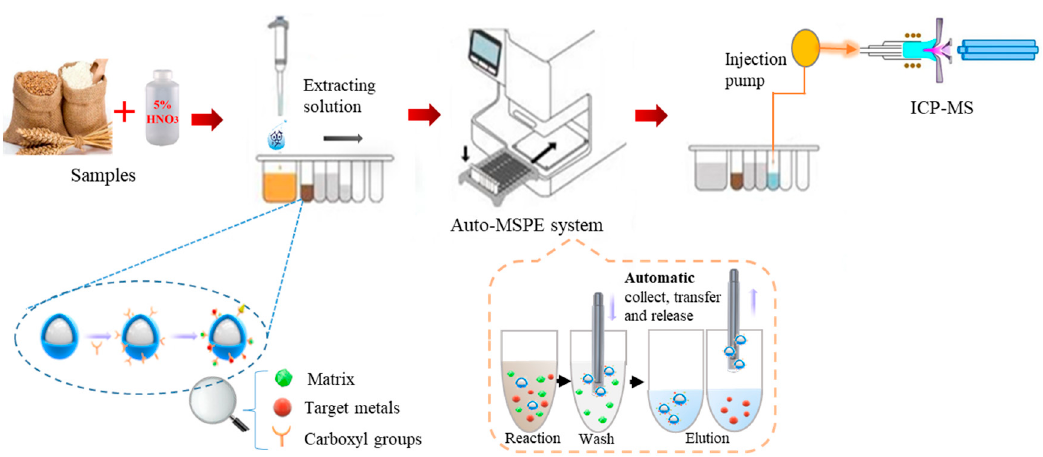
Figure 1. The process of the automated magnet-controlled pretreatment system.